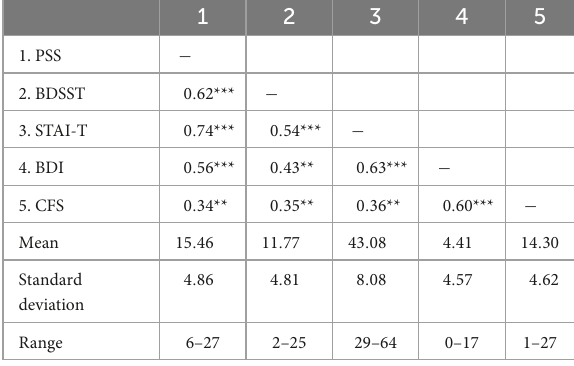
TABLE 1 Correlations, means, standard deviations of scale variables ( N =